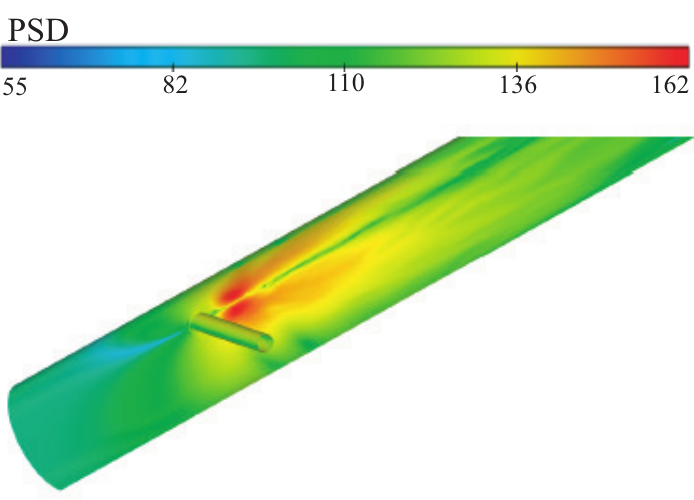
Figure 13. Spectrum of pressure fluctuations on the walls at f = 167.5 Hz.